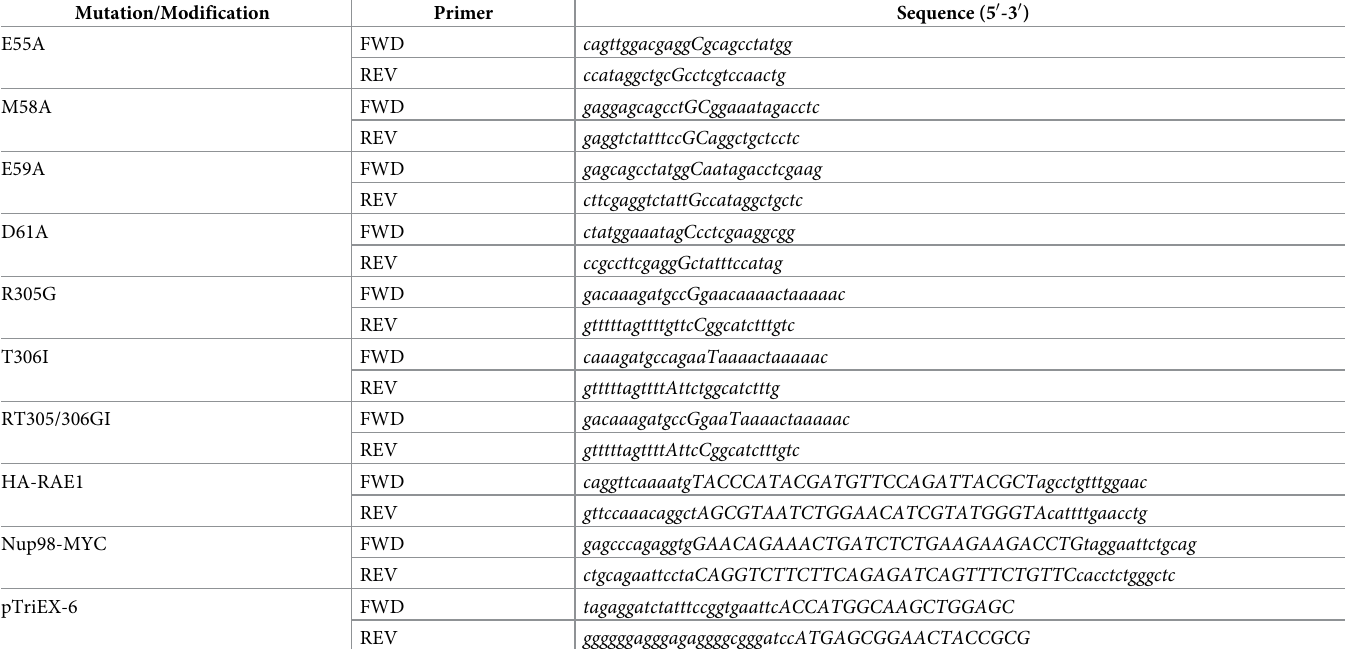
Table 1. Sequences of Primers used for